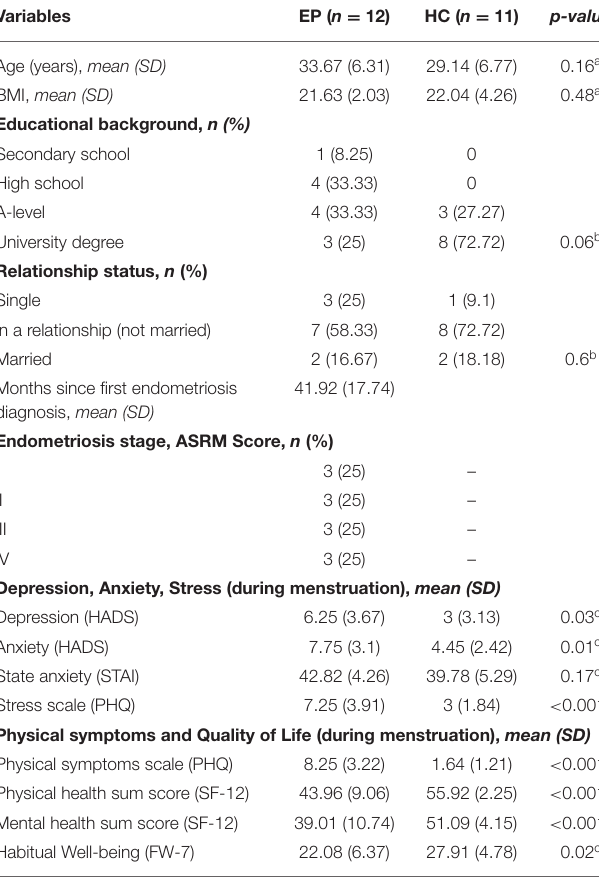
TABLE 1 | Socio-demographic, health-related, and diagnostic characteristics of study participants.